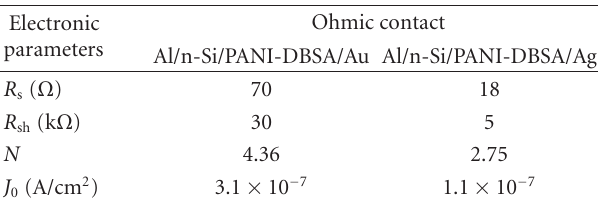
Table 1: Characteristic electronic parameters of Al/n-Si/PANI- DBSA herterojunctions under darkness using Au or Ag as Ohmic contact.